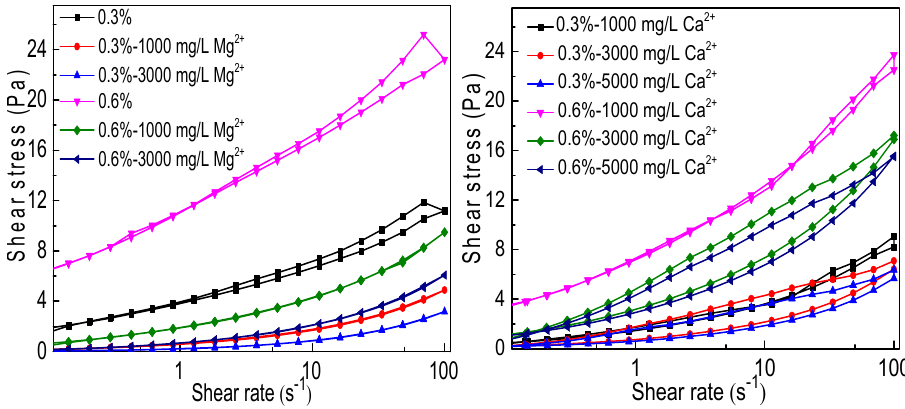
Figure 16. Thixotropy of different DiPHAM concentrations and with different concentrations of ions.